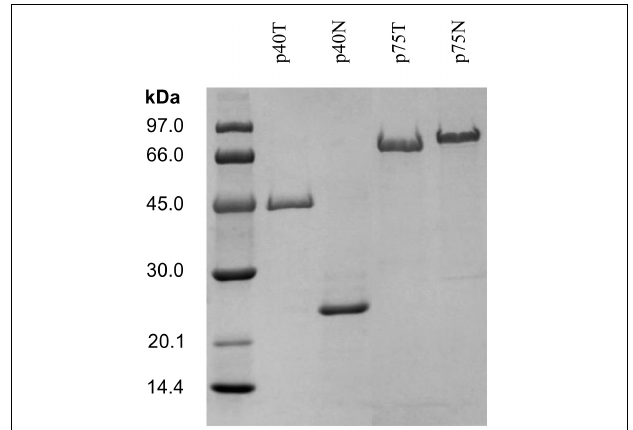
FIGURE 3 | SDS-PAGE of the NiNTA purified his-tagged proteins P40 (P40T) and P75 (P75T) and their respective amino terminal domains, P40N and P75N. In order to reduce the figure’s size, part of the gel has been omitted. The complete gel is shown in Supplementary Figure S3 .